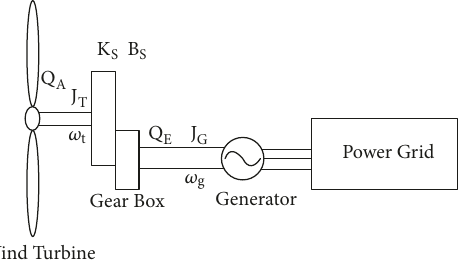
Figure 1: System of wind driven